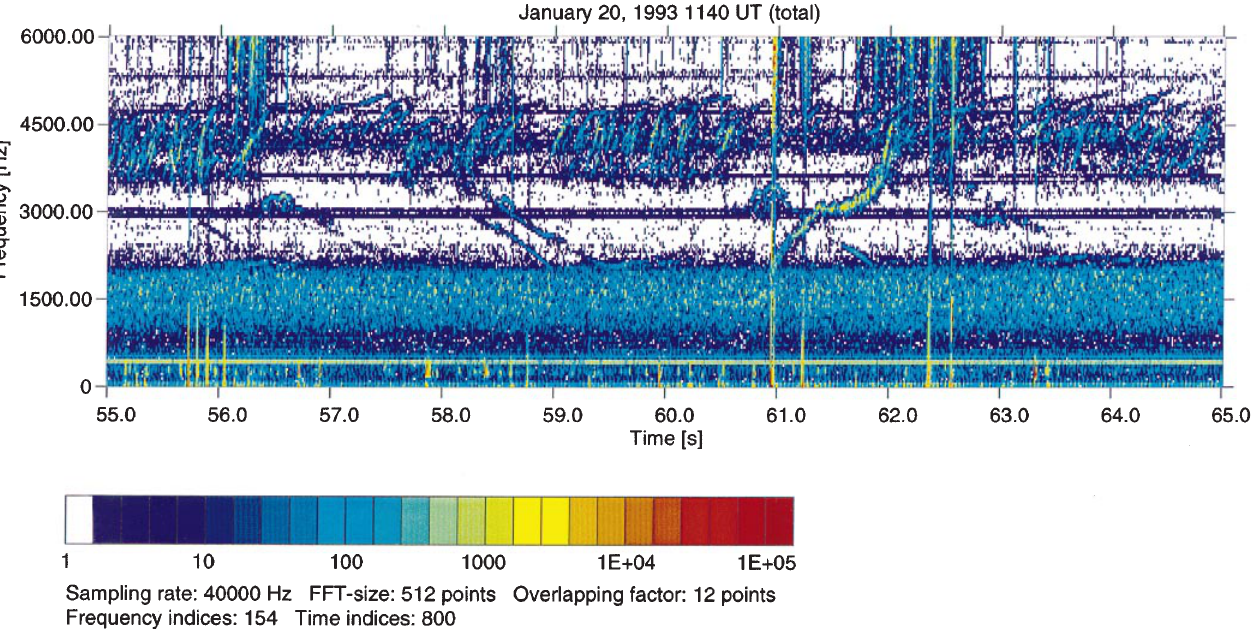
Fig. 2. Long fallers triggered by the doublet at 2950/3050 Hz. PLHR in the vicinity of 4 kHz has triggered a disorderly chorus-like emission composed of a profusion of slow risers